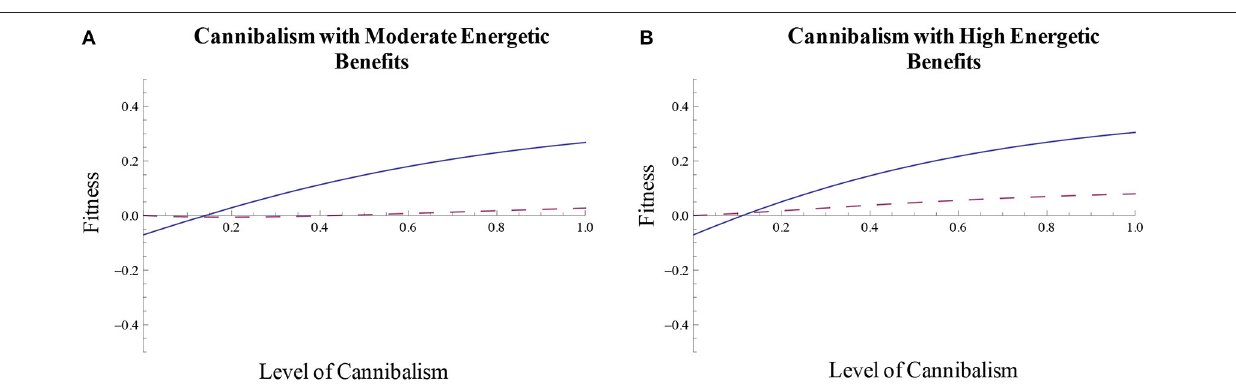
FIGURE 5 | Energetic benefits affect the fitness of filial cannibalism. When filial cannibalism provides (A) moderate or (B) high energetic benefits to parents, fitness associated with filial cannibalism can be positive even when there are no effects of density on within-clutch mortality (dashed line). The solid line reflects the scenario in which there are density effects on egg